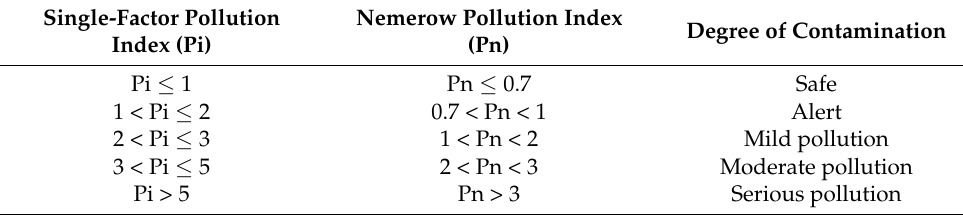
Table 1. Evaluation criteria for heavy metal